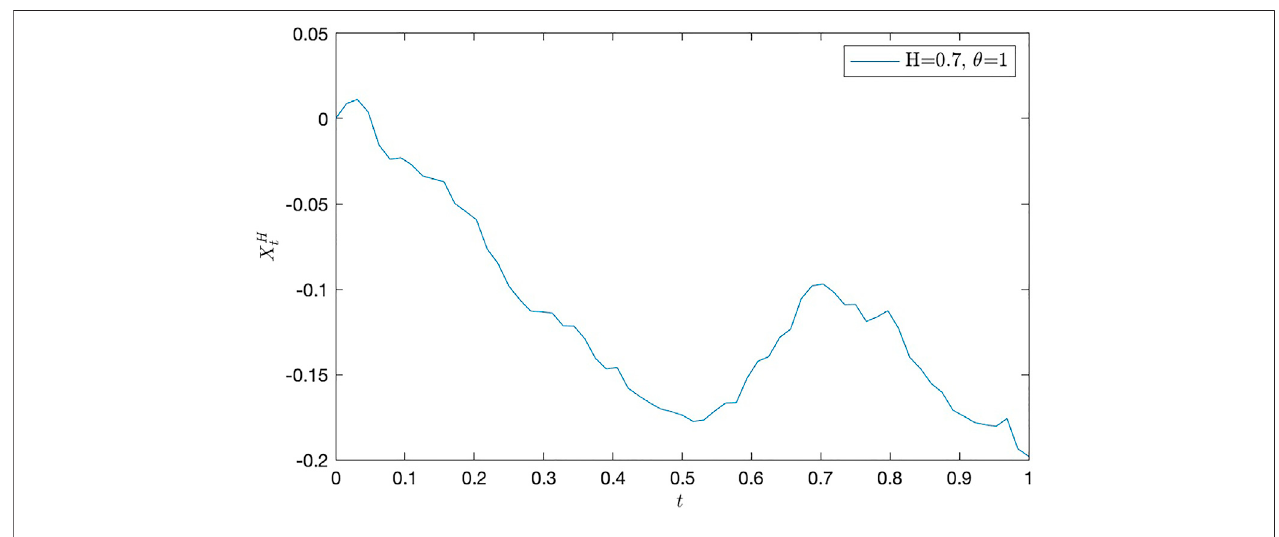
FIGURE 1 | Path of X H with θ (cid:1) 1 and H (cid:1) 0.7.